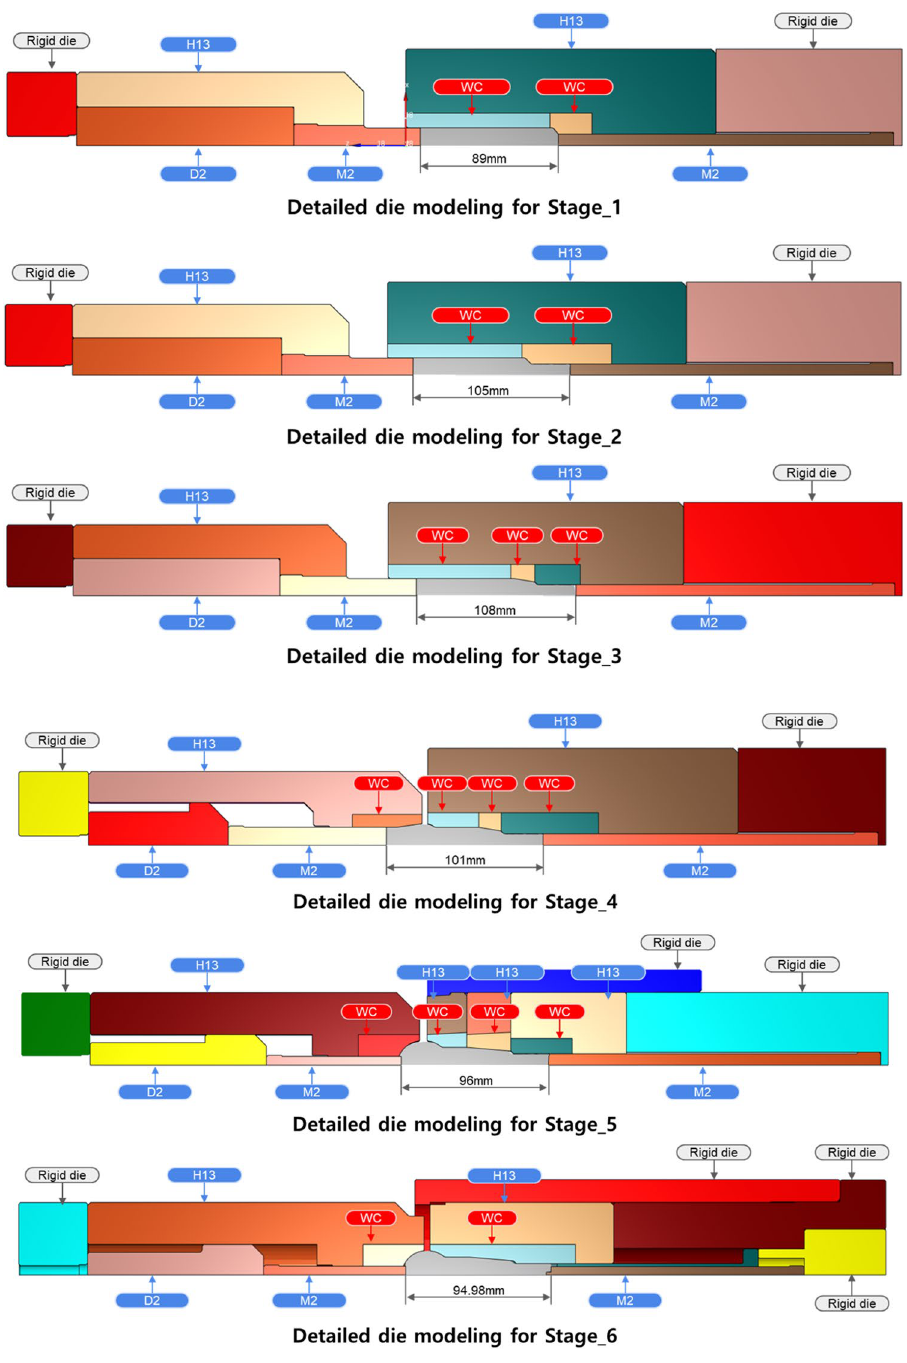
Figure 8. Detailed die modeling for ball stud forming procedure.